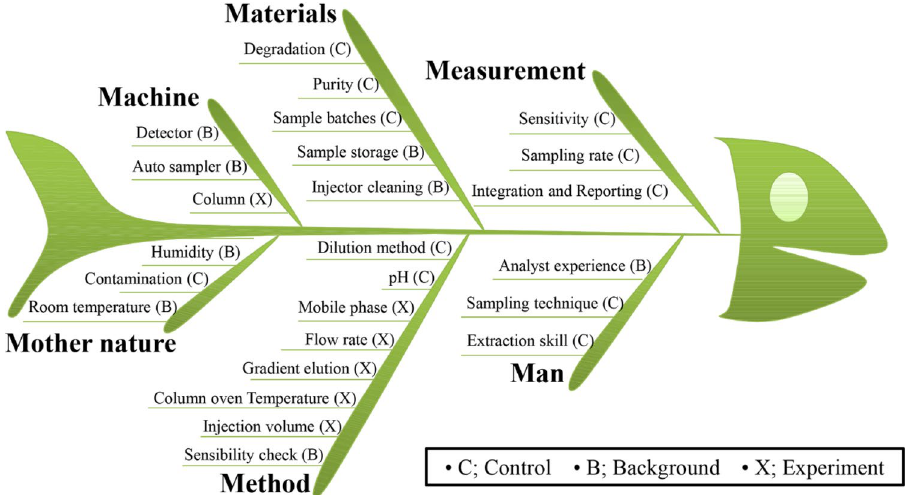
Figure 2. Ishikawa Fishbone in Six Sigma of the UHPLC-PDA performance.